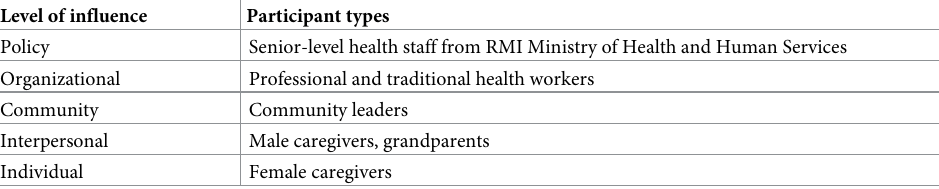
Table 1. Theoretical sampling framework with participant types by level of socio-ecological